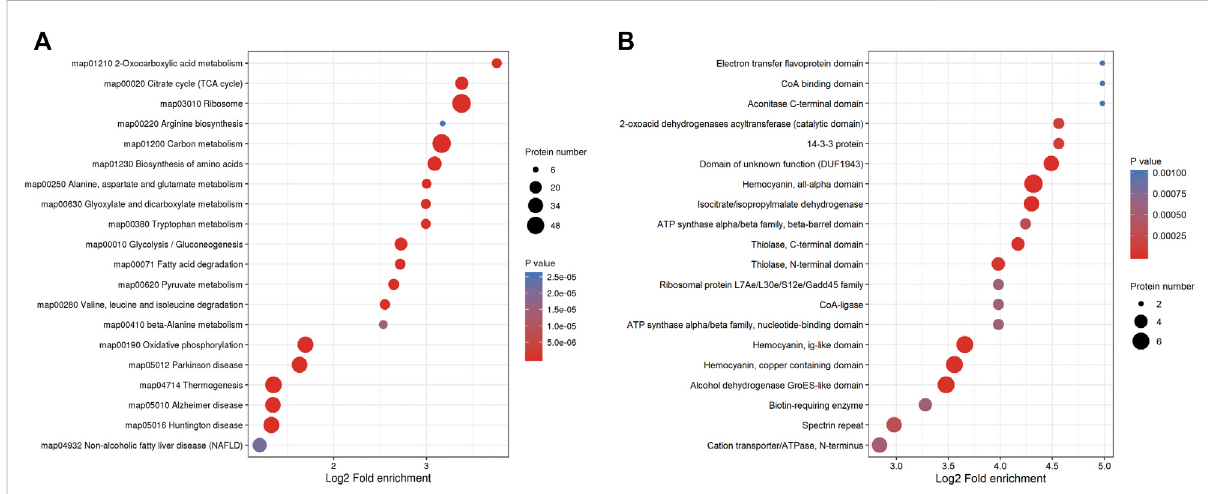
SystematicenrichmentanalysisofKlacproteinsin F.occidentalis . (A) KlacproteinsenrichmentanalysisbasedontheKEGGpathway. (B) Protein domain-based Klac proteins enrichment